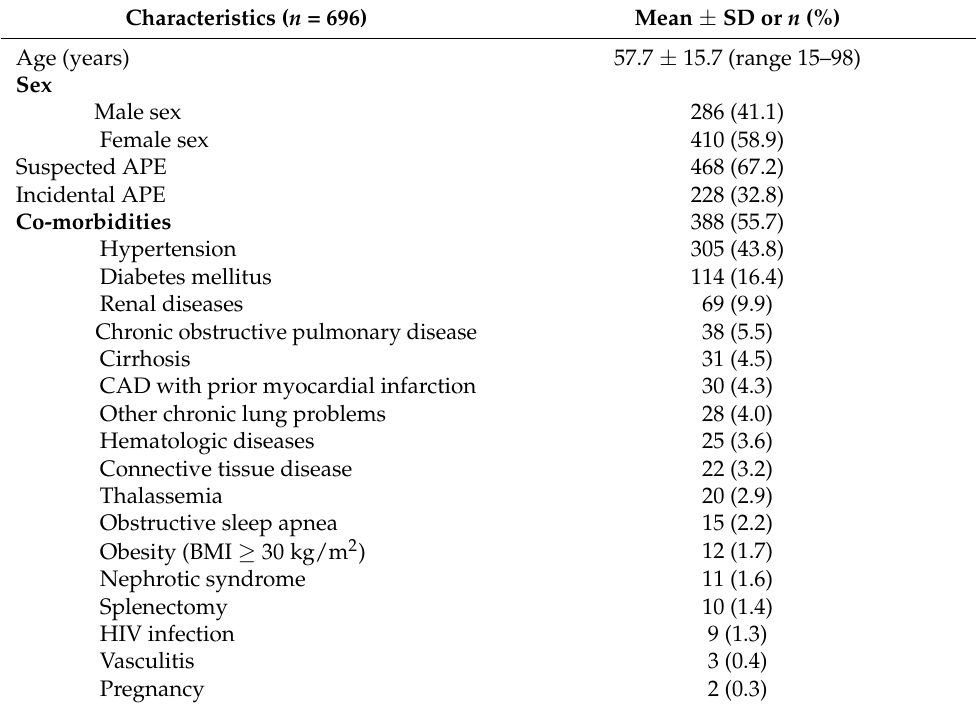
Table 1. Patient Characteristics and Co-morbidities.